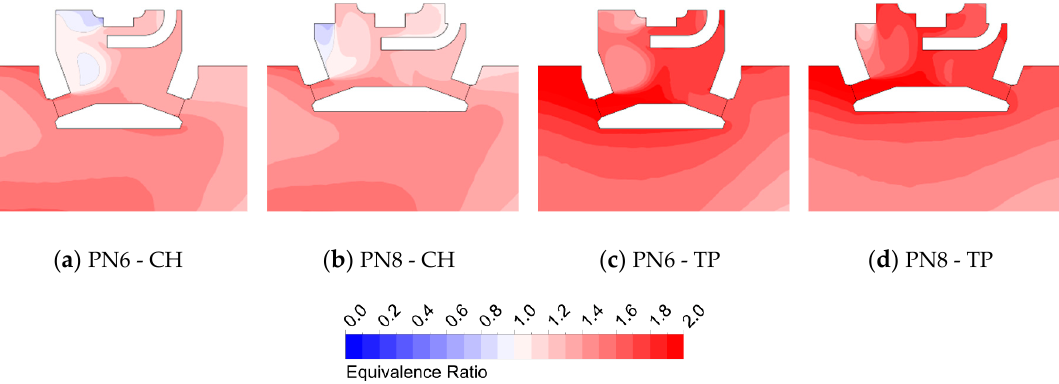
Figure 22. Equivalence ratio contours inside the prechamber at TDC for the 2500 rpm and 10% of load case: comparison between the two prechamber geometries for both injection strategies.